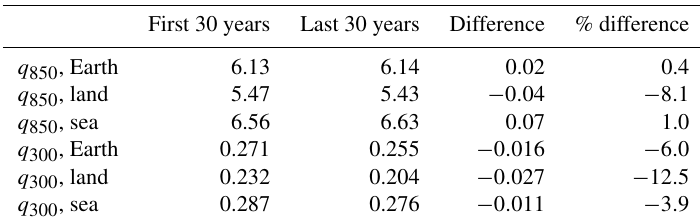
Table 4. Specific humidity at 850hPa ( q 850 ) and at 300hPa ( q 300 ) in gkg − 1 per 30-year climatic period and the resulting differences. Data are from the NCEP–NCAR reanalysis.